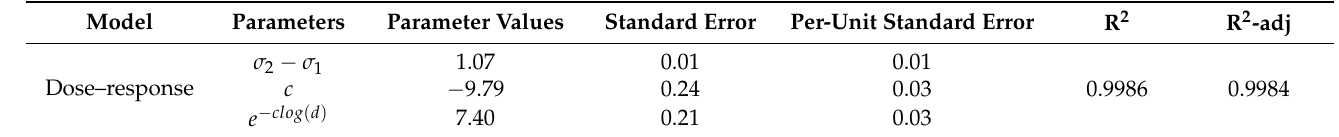
Figure 6. Comparing the Gaussian model with experimental measurement ( a ) n = 1 ( b ) n = 2.